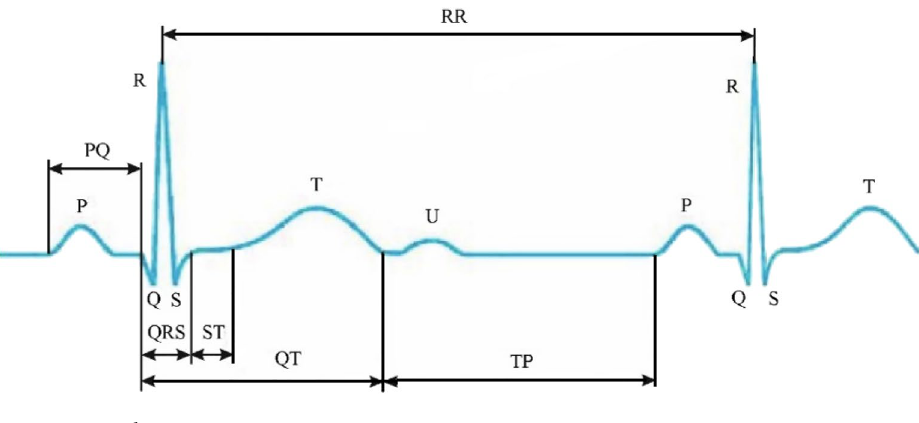
Figure 1. Cardiogram